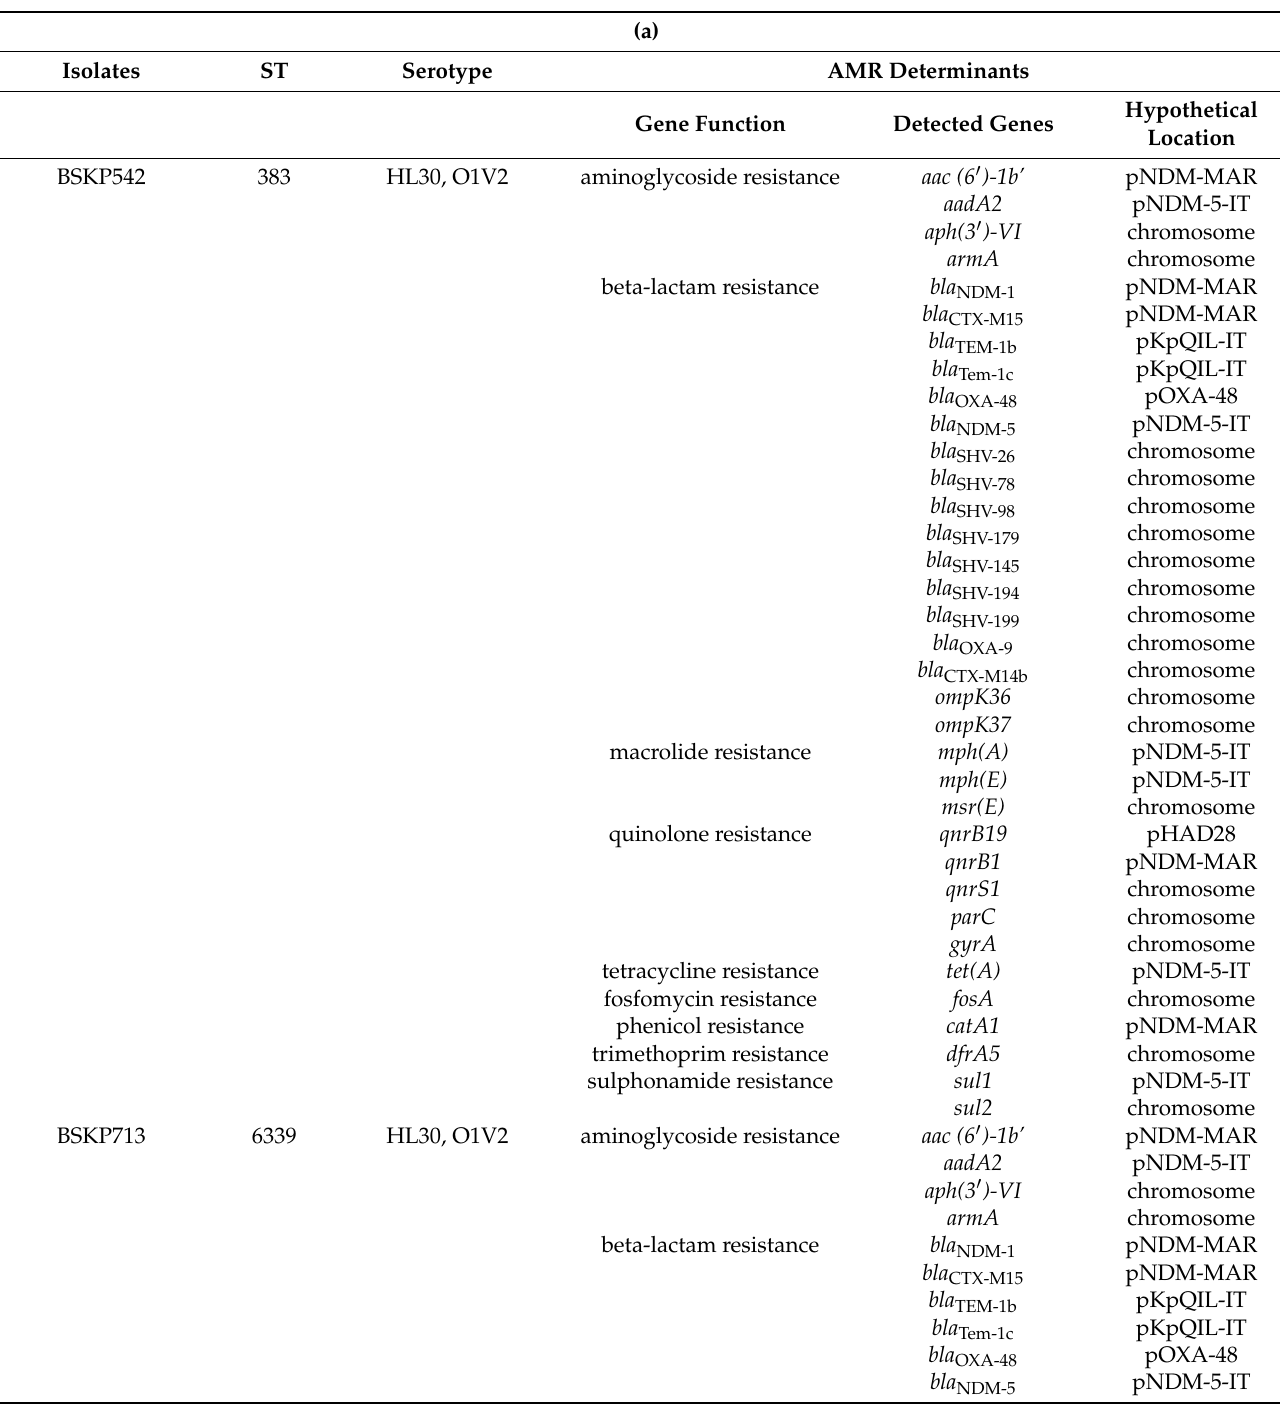
Table 2. (a) Antimicrobial resistance (AMR) determinants of the two cefiderocol-resistant Klebsiella pneu- moniae isolates. (b) Virulence determinants of the two cefiderocol-resistant Klebsiella pneumoniae